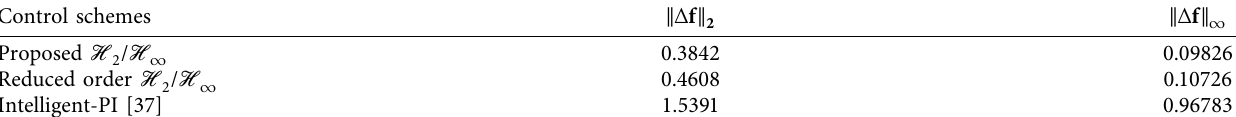
Table 2: Scenario I’s norm specifcation.